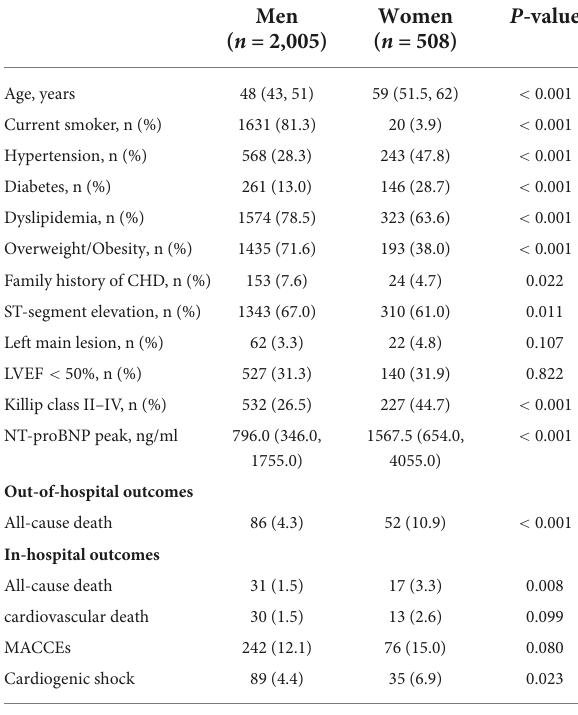
TABLE 3 Gender grouping analysis of premature acute myocardial infarction (AMI)